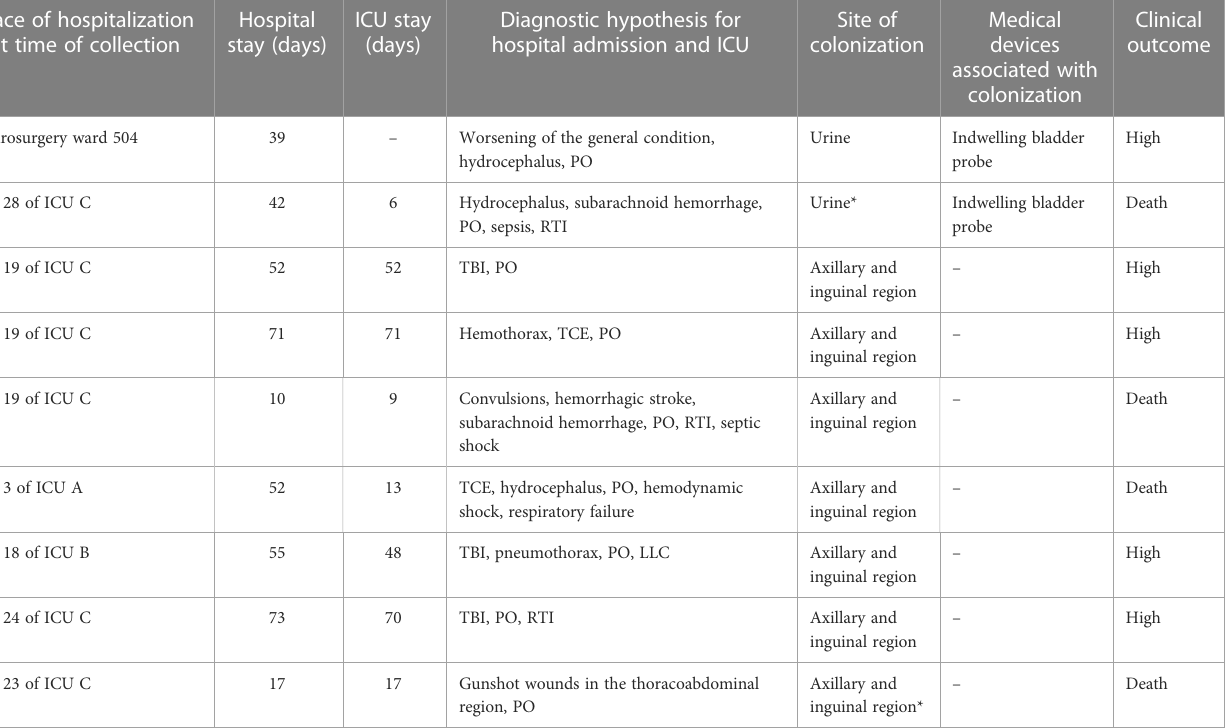
RT-PCR COVID-19, real-time polymerase chain reaction test for the detection of SARS-CoV-2. M, man; W,